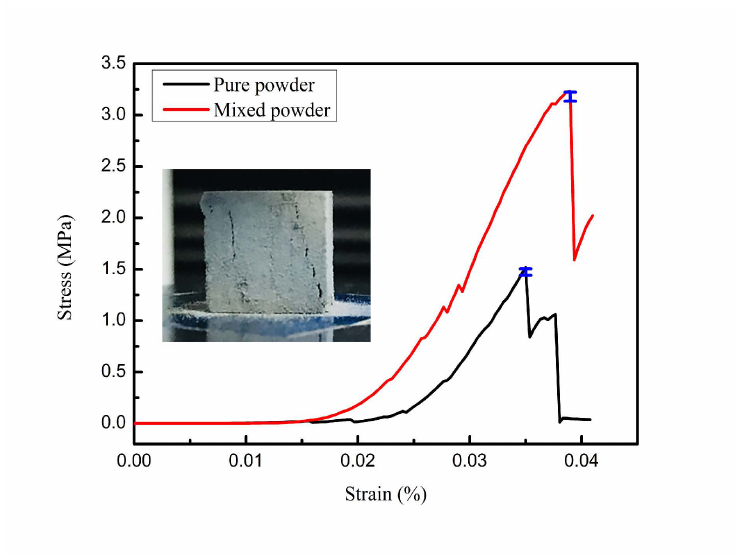
Figure 4. Stress-strain curves obtained from the binder jet 3D printing (BJ3DP) Ti6Al4V green